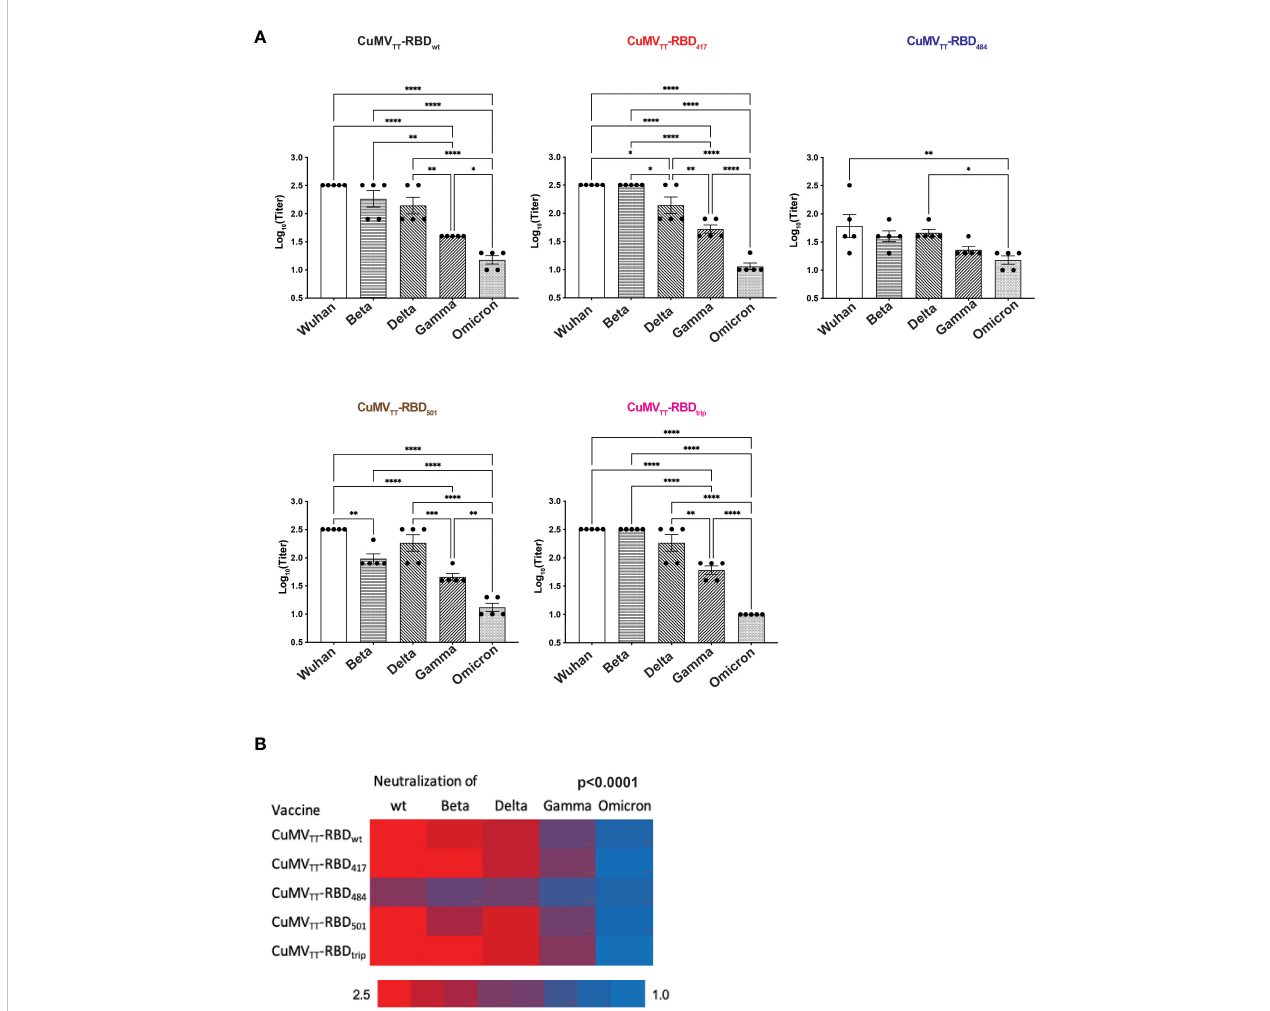
FIGURE 5 Neutralization of wt Wuhan and Beta, Delta, Gamma and Omicron variants by d49 sera. (A) Titers were expressed as the sera dilution times to form 100% CPE. One-way ANOVA analysis was performed in Prism 9 (n=5), a =0.5 and statistical signi fi cance was displayed as p ≤ 0.05 (*), p ≤ 0.001 (**), p ≤ 0.005 (***), p ≤ 0.001 (****). (B) Heatmap of neutralization titers of wt and VOCs by immunized sera, Chi2-test was